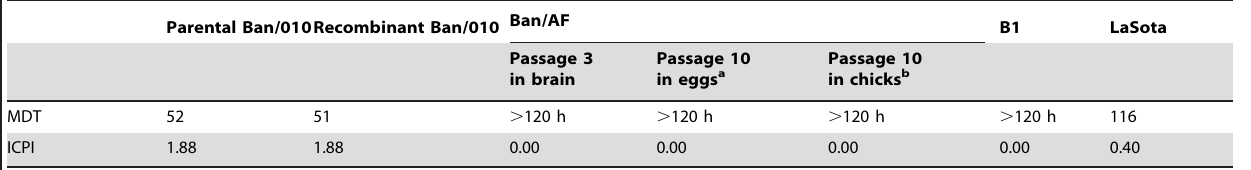
Table 4. Pathogenicity and stability of the Ban/AF